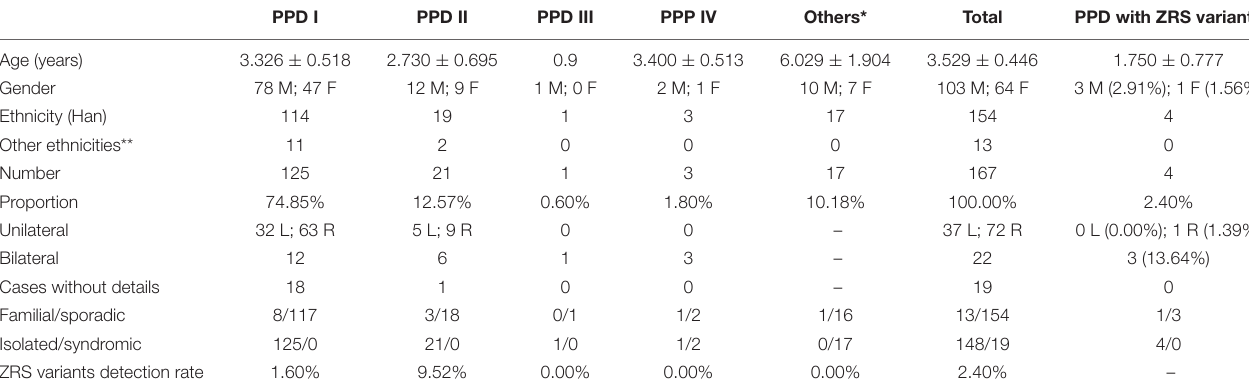
TABLE 3 | Characteristics and clinical phenotypes of all the subjects.